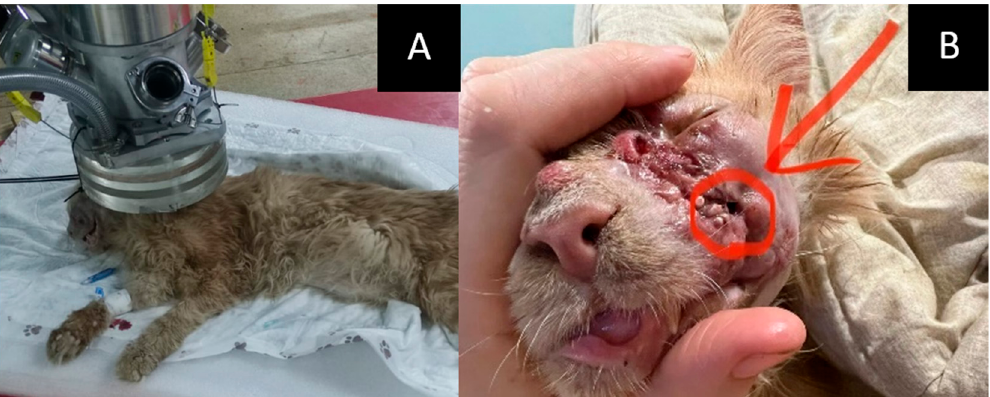
Figure 3. Male cat “Sausage” (6 years old) with squamous cell carcinoma in the left nasal area (33 × 26 × 26 mm) with bone destruction, causing impaired nasal breathing and nasal discharge, and regional lymphadenopathy. Animal positioning under the lithium target within the beam shaping assembly during neutron irradiation ( А ) and tumor appearance after the irradiation (( B ), arrow and the circle). Two months after GdNCT, there were signs of tumor recurrence in the back of the nose, upper jaw, and corner of the eye.